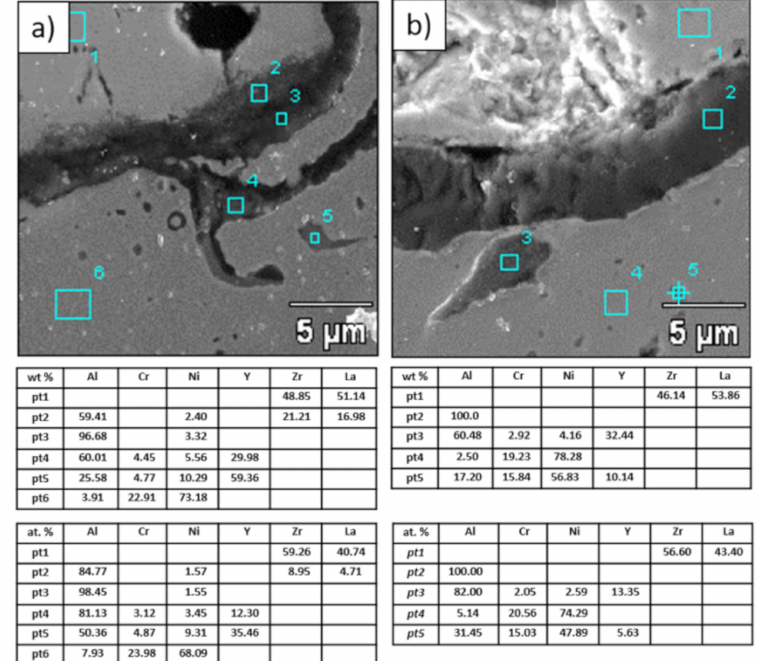
Figure 20. Analysis of chemical composition in micro-areas of TGO zone after 500 h of oxidation at a temperature of 1100 ◦ C—monolayered La 2 Zr 2 O 7 TBC (SEM): ( a ) zone of the bond-coat bottom and ( b ) zone of the bond-coat top.